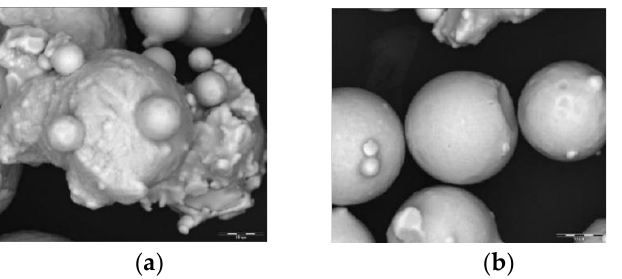
Figure 4. Powder particle shape and morphology: ( a ) particles with satellites joined during solidifi- cation; ( b ) smooth, round particles.